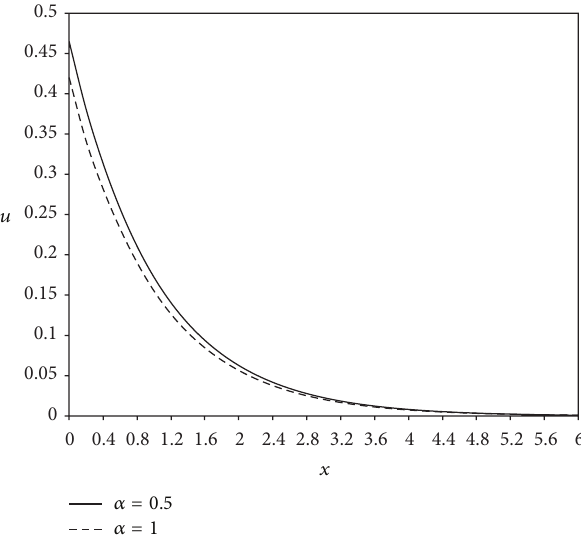
Figure 1: Displacement distribution 𝑢 for different values of 𝛼 at 𝑡 = 0.1 .